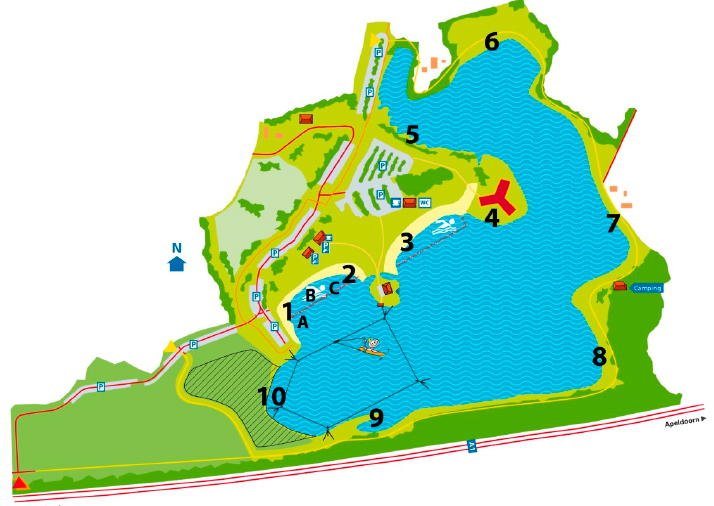
Figure 1. Recreational water lake Zeumeren, The Netherlands, with beaches 1 — 10 and sampling points. A — C. Beaches 1 — 2 and 3 are the official beaches, which are sampled for monitoring according to the EU BWD [18]. Sampling points for the outbreak investigation: A — water and subsurface sandy soil sample taken, B and C — subsurface sandy soil samples taken.